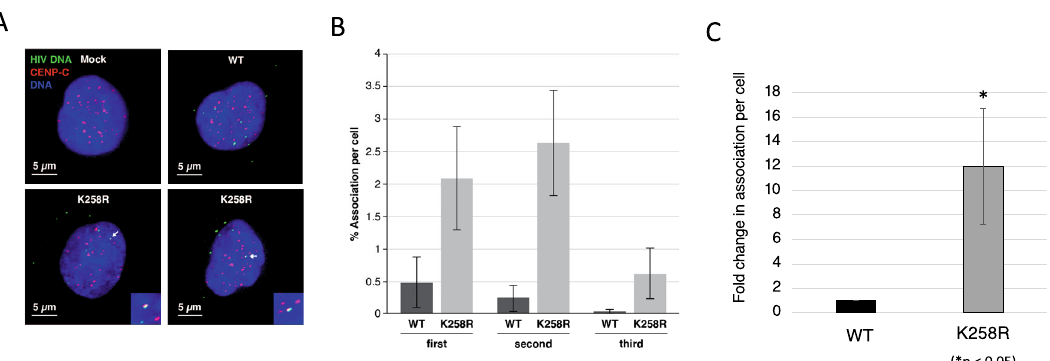
Fig. 6 Enrichment of K258R IN mutant HIV-1 in centromeres. HeLa cells were infected with WT and K258R for 16 h at MOI 10. Infected cells were stained for CENP-C and then subjected to HIV-1 DNA FISH. A Representative images of the association between CENP-C (red) and HIV-1 DNA (green). The association indicated by arrows was represented in an inset. Scale bars; 5 μ m. B Quanti fi cation of HIV-1 DNA signals co-localizing with CENP-C. HIV-1 DNA signals detected in the nucleus were counted for the colocalization with CENP-C in every single z-section of each nucleus. An average of 50 nuclei was analyzed in each experiment. The average percent association per cell is shown for each of three biological replicates (±SEs; n = approximately 50 for each bar). C Fold change in K258R association with CENP-C over WT. Data is average ± SEs of three independent experiments. Statistical signi fi cance was determined by two-tailed Student t test. * p < 0.05. Source data are provided as a Source Data fi